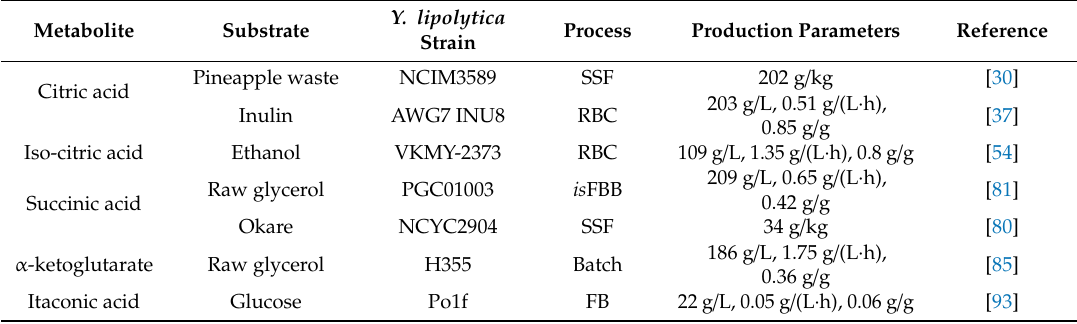
Table 1. Process parameters of the most promising organic acids produced by Y. lipolytica . SSF: solid state fermentation; RBC: repeated batch culture; is FBB: in situ fibrous bed bioreactor; FB: